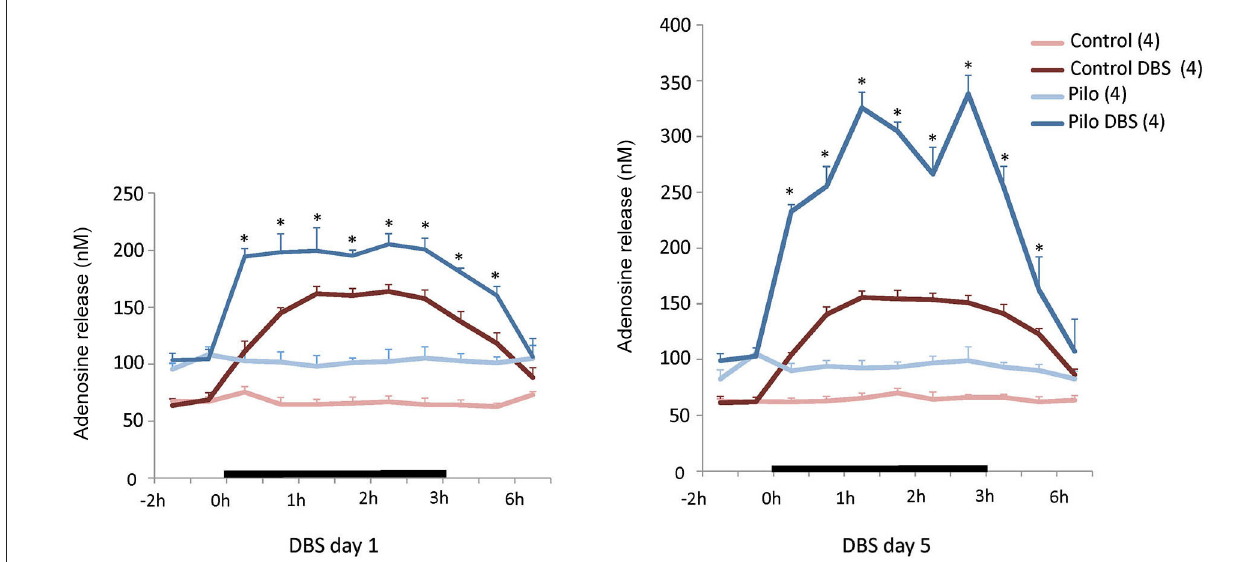
seen but adenosine levels in Pilo + DBS animals were almost twice as high as those recorded on stimulation day 1. Values are means and SEM. N = 4 for all groups. * p < 0.012 (day 1) and p < 0.0062 (day 5) Pilo + DBS compared to Pilo + Sham, Bonferroni-corrected tests. Other significant comparisons are omitted for the sake of